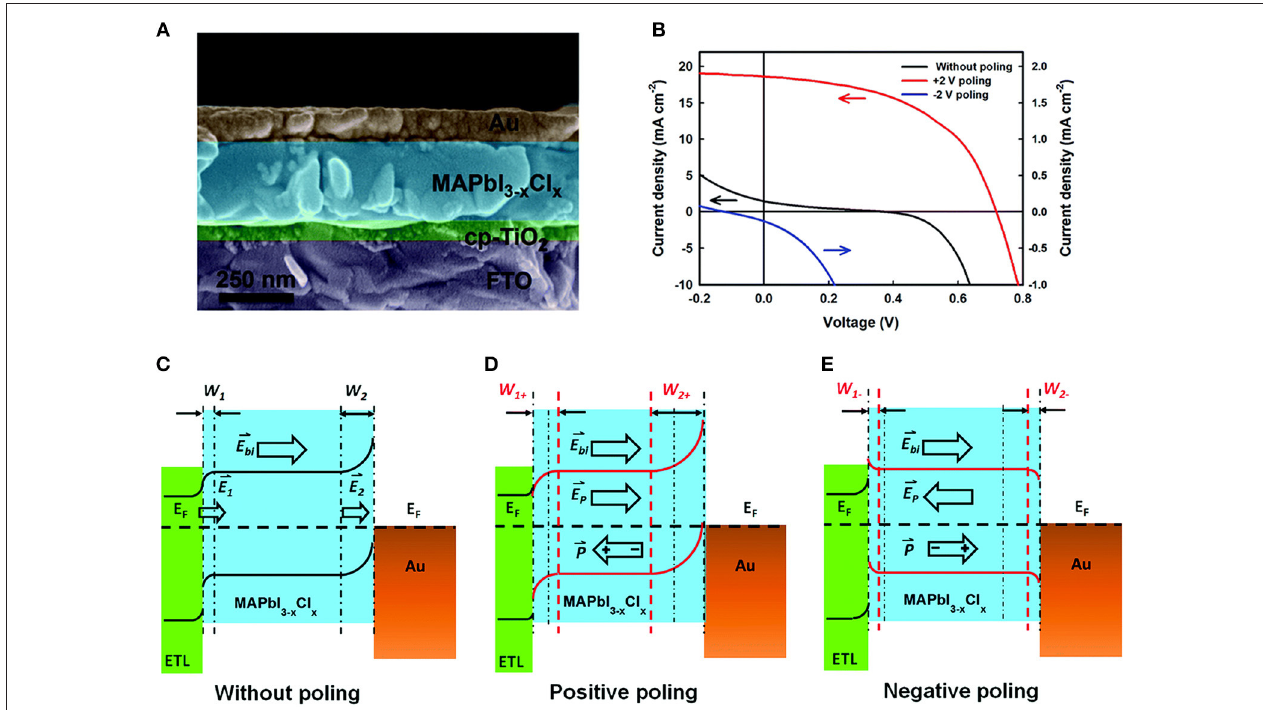
FIGURE 8 | Band-bending at TiO 2 /MAPbI 3 − x Cl x /Au heterojunctions. (A) SEM of the ferroelectrics-based solar cell (left) and J–V plot (right). (B) Proposed electronic band structure under different polarization conditions. (C) Without poling. (D) Positive poling. (E) Negative poling. Figures adapted from Chen et al. (2015). Copyright 2015 Royal Society of